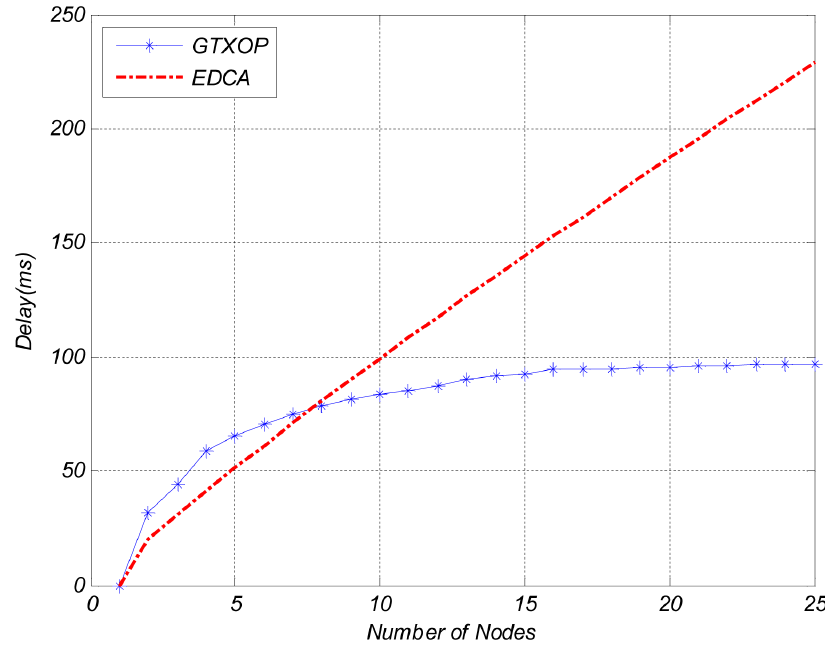
Figure 2. Throughput Comparison of GTXOP and EDCA.